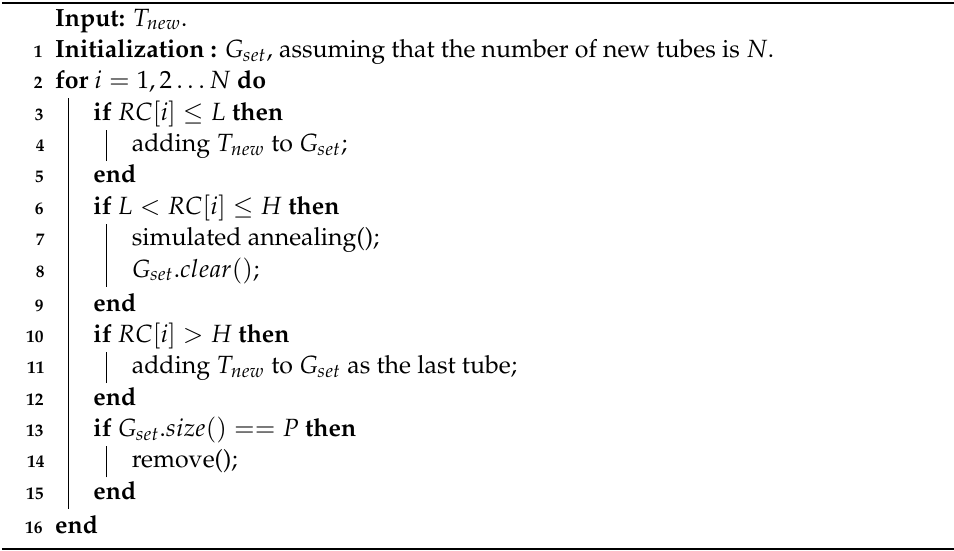
Figure 3. Tube addition phase. The length of G set is updated by T e − T s . Algorithm 2: Pseudocode for the addition of new